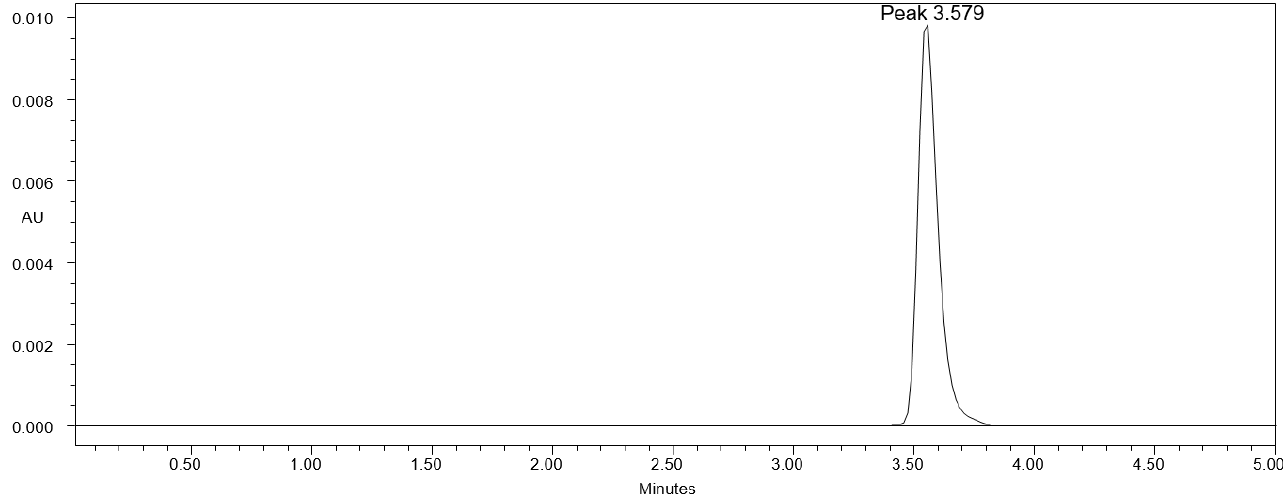
Figure 2. A greener high-performance liquid chromatography (HPLC) chromatogram of CCM in solution derived using ethanol: ethyl acetate (83:17 v/v ) greener eluent system.